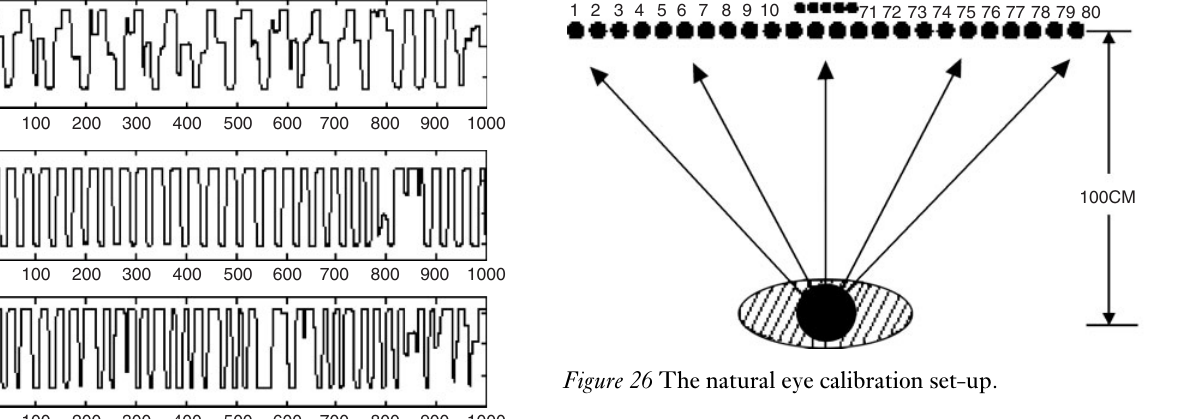
The subject is asked to fixate at the left-end target, and move the eye to the next target until he/she reaches the right-end target. The corresponding voltage is recorded and a calibration curve generated, as shown in Fig. 27. The deflection range of the subject here is 102 ◦ . The calibration curve is quite linear from − 30 ◦ to + 40 ◦ . After the calibration curve is obtained, the eye move- ment signal is fed to the micro-controller to control the artificial eye model, as shown in Fig. 28. The subject is asked to track the moving target with his/her eye. The eye position signal is fed to the controller to move the artificial eyeball so that it will have the same line of gaze as the natural eye. A pilot study has been carried out. The whole